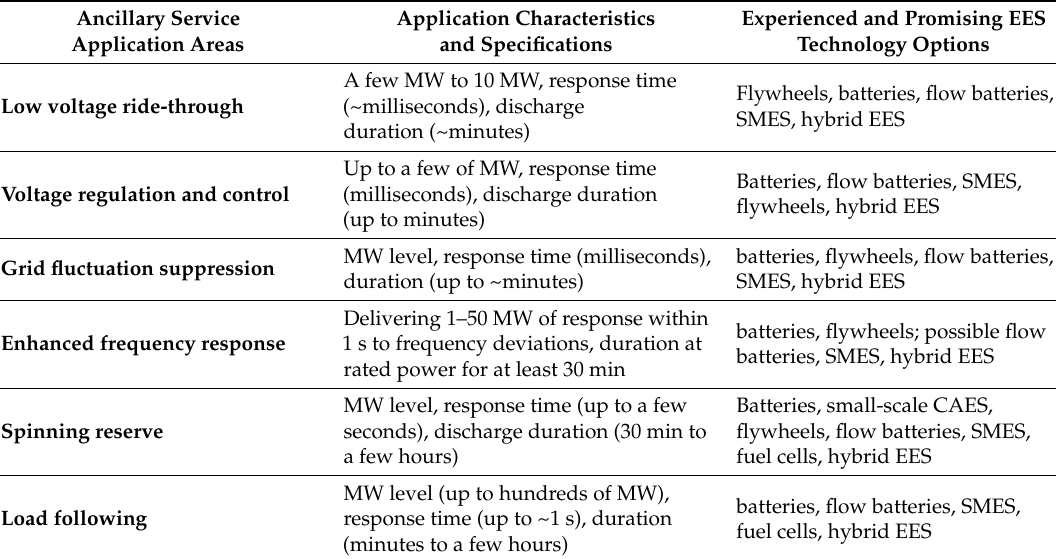
Table 10. Analysis of EES options to some grid ancillary services